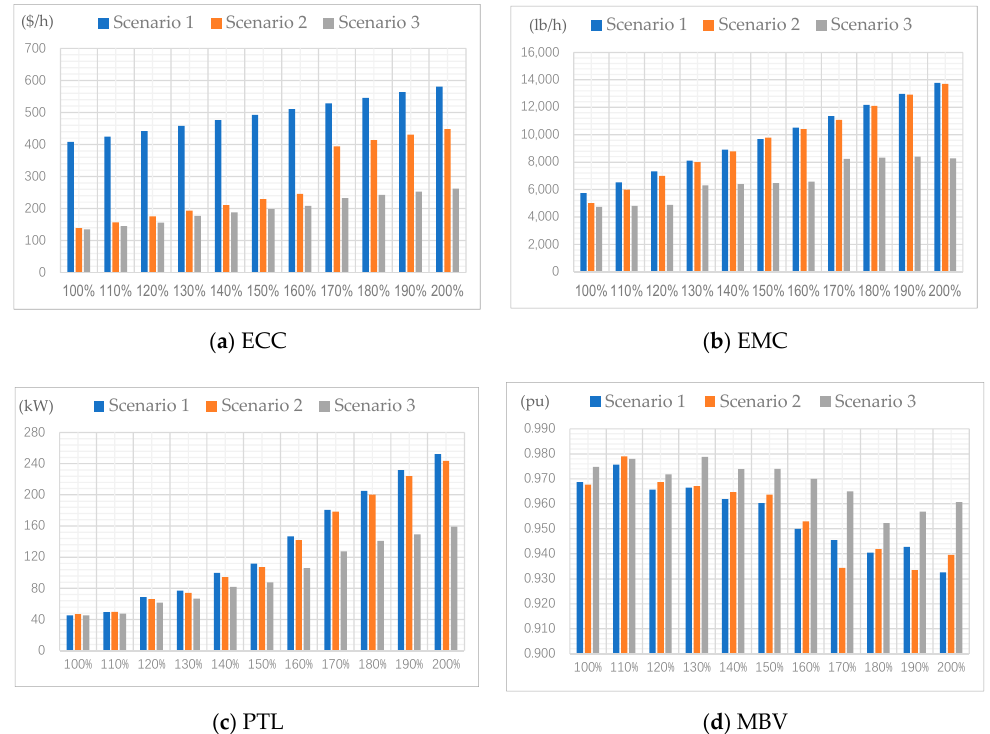
Figure 3. Comparison of ECC, EMC, PTL, and MBV under changing power demand in three scenarios.